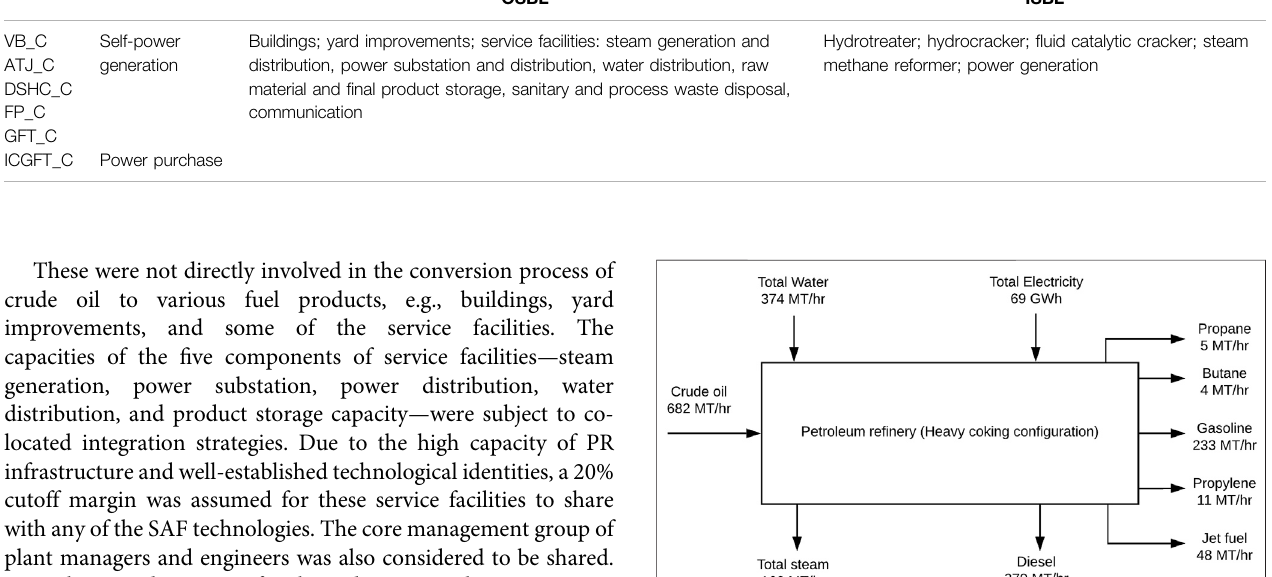
TABLE 4 | De fi ned features of integrated scenarios – repurposed; corn stover was the feedstock. Scenario